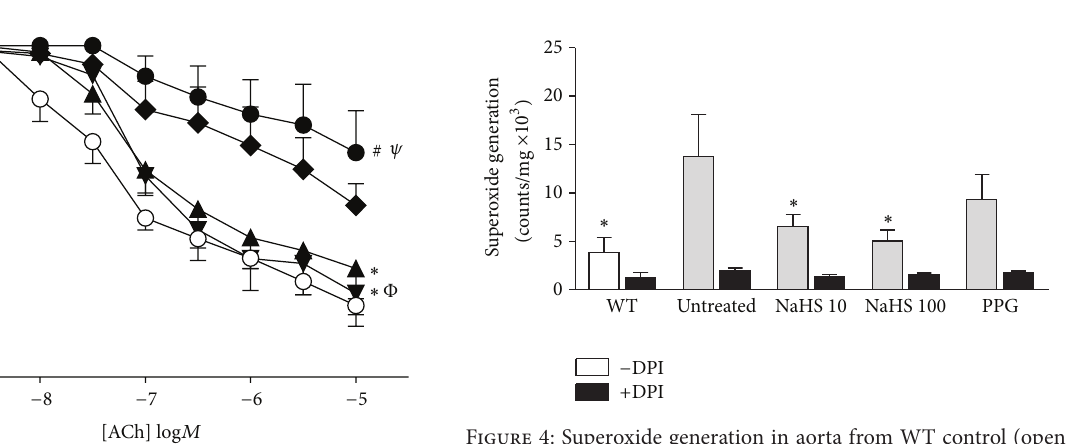
Table 2: Effect of chronic treatment with NaHS or PPG on endo- thelial function.